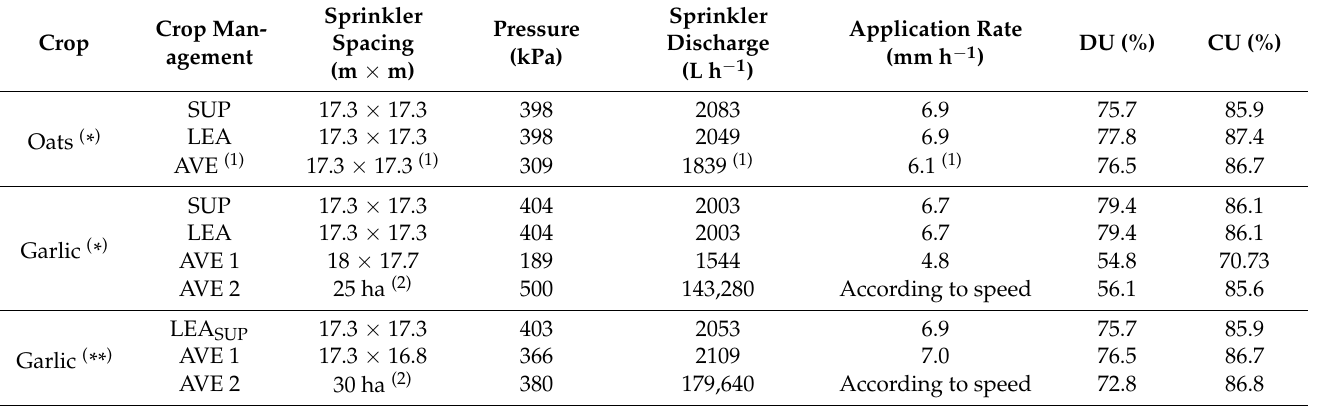
Table 2. Characterization of monitored irrigation systems.